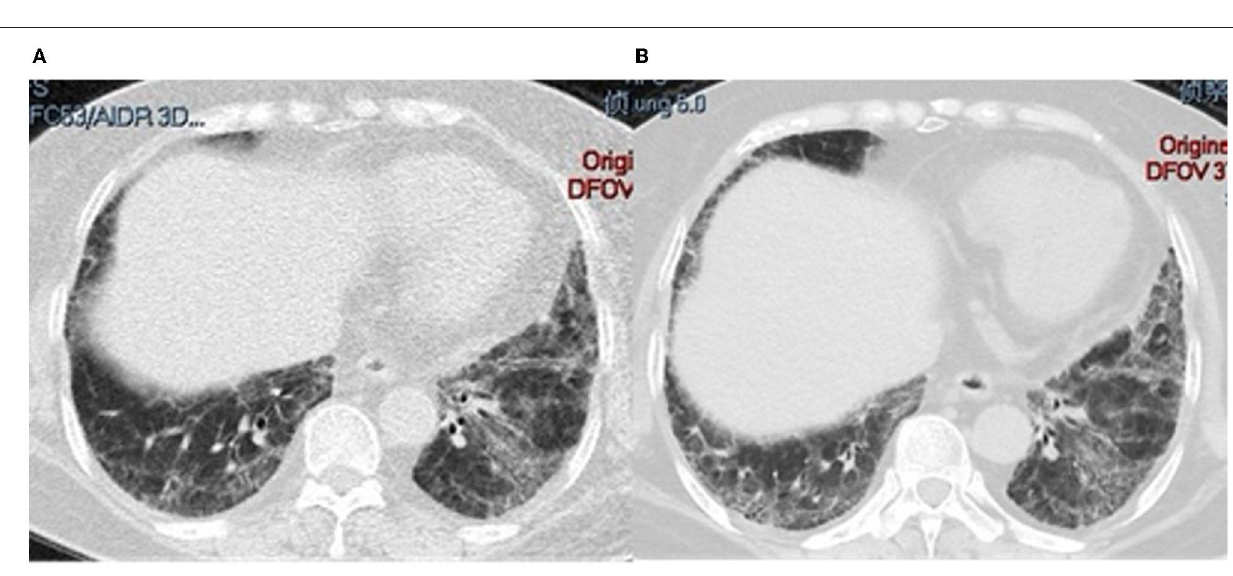
FIGURE 5 | Lung CT changes in a 41-year-old man with PM/Scl-75 and − 100. (A) CT at onset; (B) ILD progression after 8 months of treatment with an anti-fibrotic